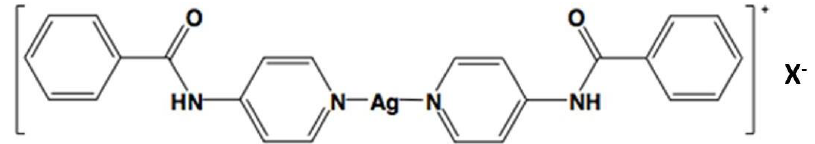
Figure 1. Structure of [Ag(NPBA) 2 ]X, where X − = NO 3 − ( 1 ), ClO 4 − ( 2 ), CF 3 SO 3 − ( 3 ), PF 6 − ( 4 ), BF 4 − ( 5 ), CH 3 PhSO 3 − ( 6 ), and PhSO 3 − ( 7 ). ( 5 ), CH 3 PhSO 3 − ( 6 ), and PhSO 3 − ( 7 ).